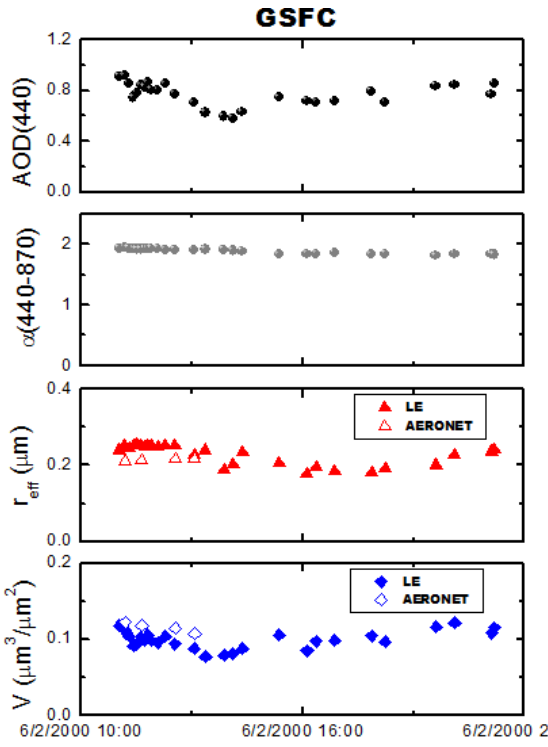
Figure 5. Time evolutions of aerosol optical depth (AOD(440)) and Ångström parameter ( α (440–870)) from AERONET Level 2.0 data at Goddard Space Flight Center on 2 June 2000. Also effective ra- dius ( r eff ) and columnar volume aerosol content ( V ) are shown, both for operational AERONET (open symbols) and linear estima- tion (full symbols)